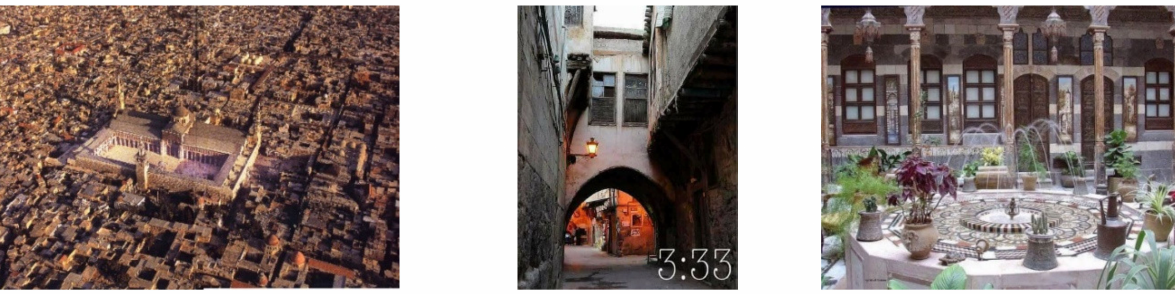
Figure 4. Various shots show the urban fabric and open spaces of old Damascus [38].